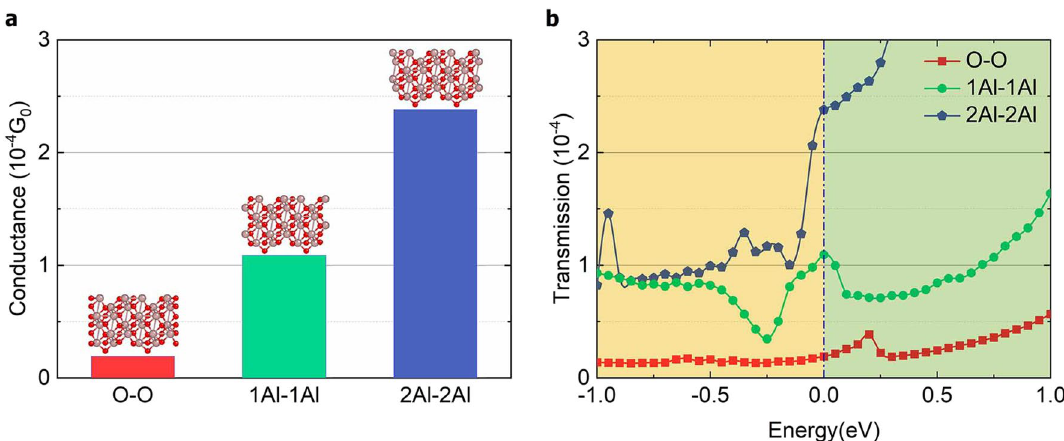
Figure 2. Conductance and transmission spectra of junction models with different termination modes at zero-bias voltage. ( a ) Zero-bias conductance of the O-terminated (O), Al-terminated (1Al), and 2Al-terminated models (2Al). ( b ) Transmission spectra at zero-bias voltage for the three models, where the red, green, and blue lines indicated O-, Al-, and 2Al-terminated on both sides of the Al 2 O 3 models respectively. The transmission coefficients at zero-bias voltage were consistent with the zero-bias